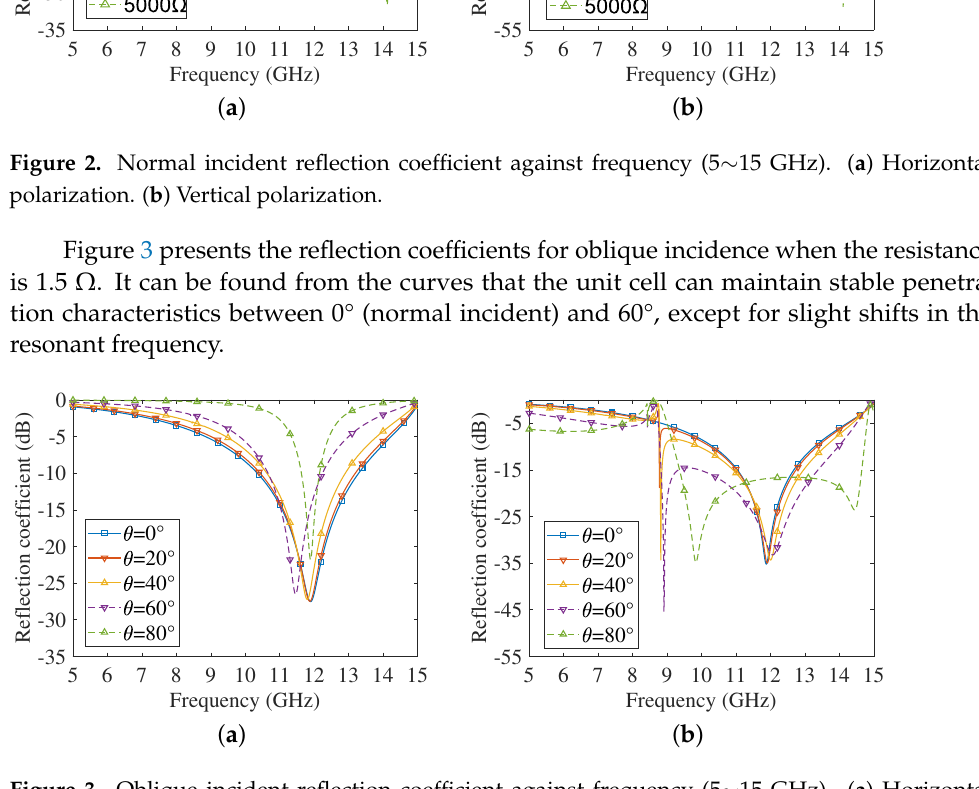
Figure 3. Oblique incident reflection coefficient against frequency (5 ∼ 15 GHz). ( a ) Horizontal polarization. ( b ) Vertical